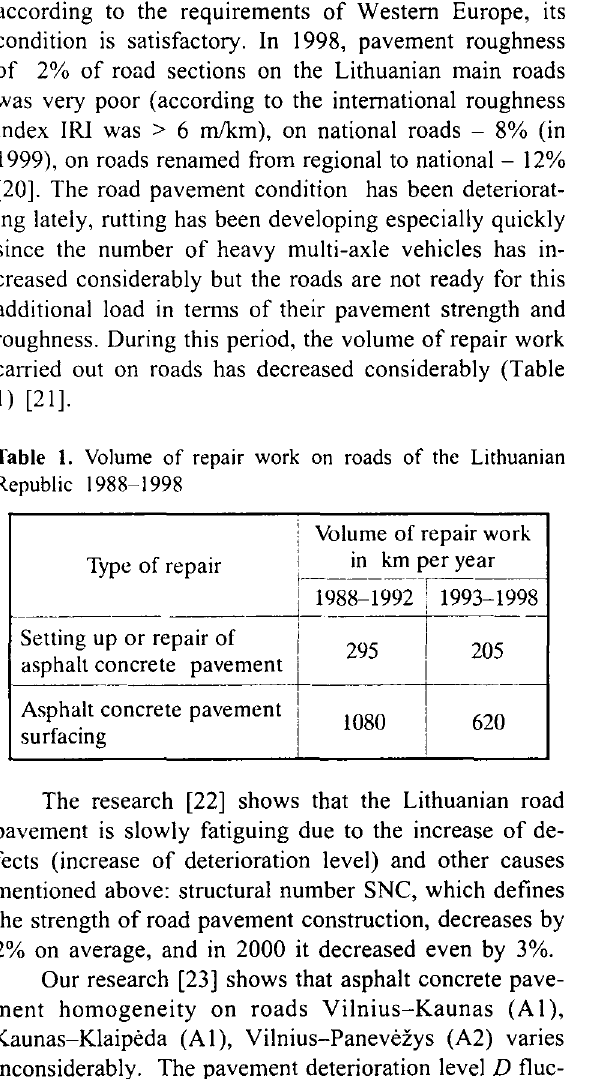
Fig 3. Dependence of pavement deterioration level D on roughness Y on the road Vilnius-Kaunas (A I)